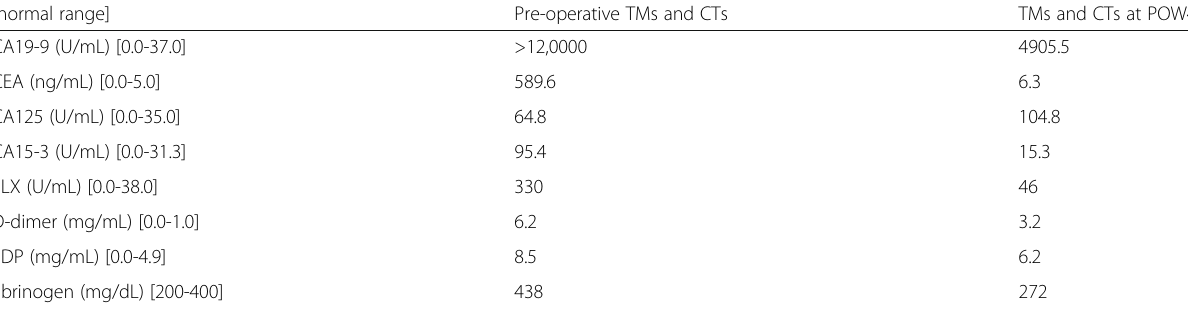
Table 1 Tumor maker levels and coagulation tests [normal range] Pre-operative TMs and CTs TMs and CTs at